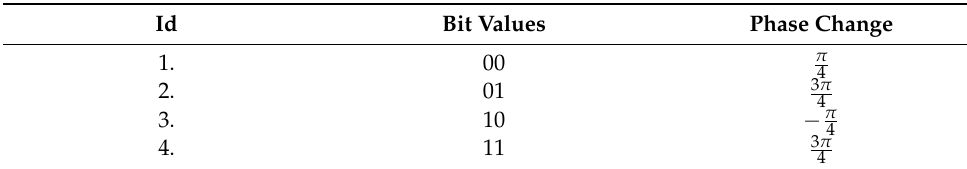
Table 2. Bit values related to phase change.